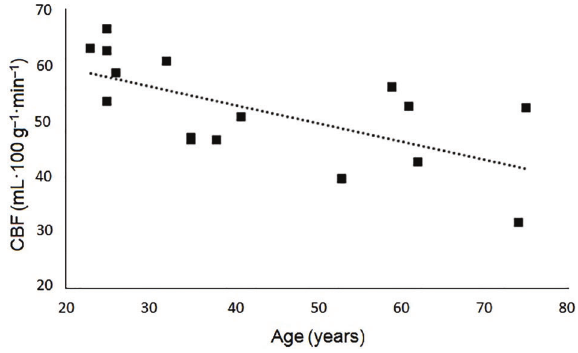
Figure 2. Decrease in normocapnic cerebral blood fl ow (CBF) with aging (linear fi t, slope= – 0.33, r= – 0.64, P=0.02).